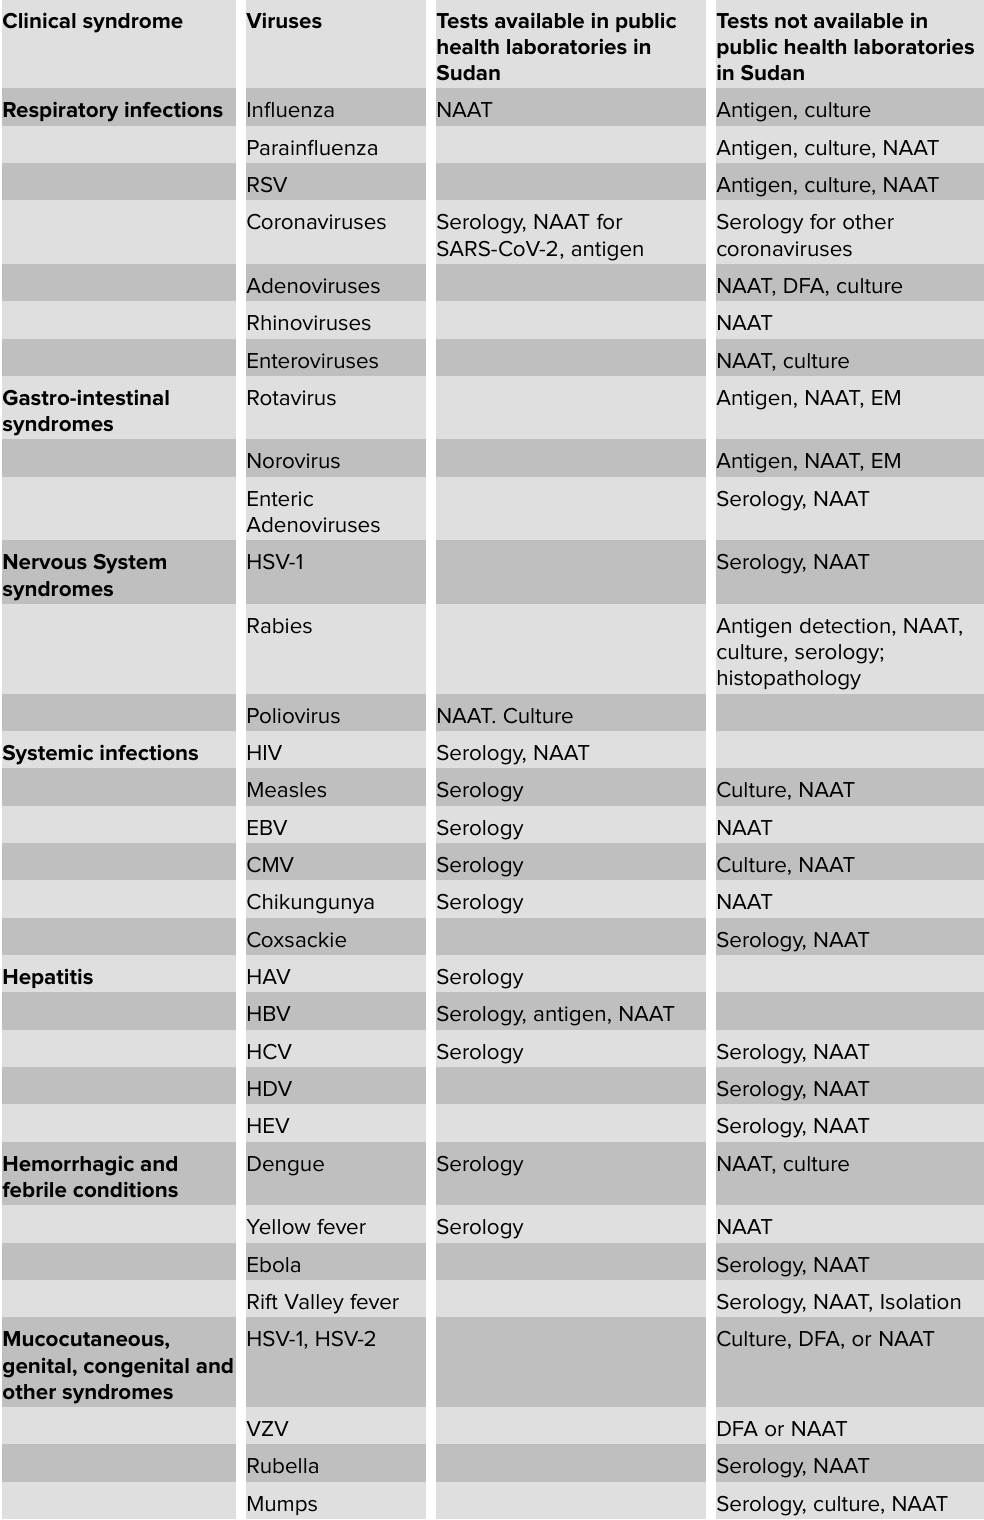
TABLE 2: Common viral syndromes and availability of their diagnostic tests in